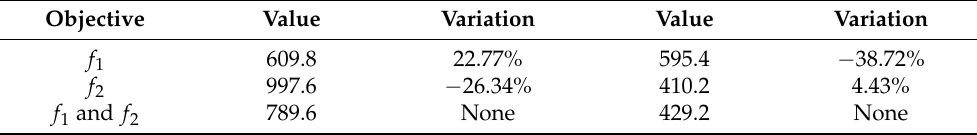
Table 9. Comparison of results between bi ‐ objective optimization and single objective optimiza ‐ tion.